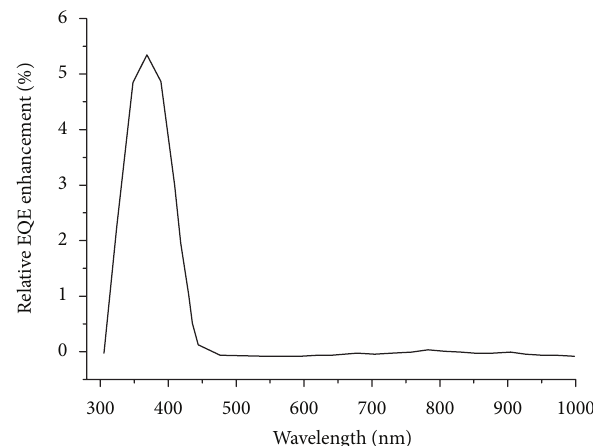
Figure 3: Relative EQE enhancement for a commercial monocrys- talline Si solar cell after the deposition of ZnS: Mn 2+ NPs.